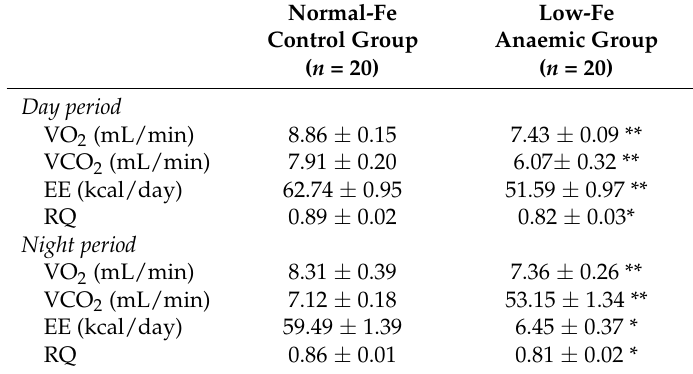
Table 5. O 2 consumption, CO 2 production, energy expenditure and respiratory quotient in control and anaemic